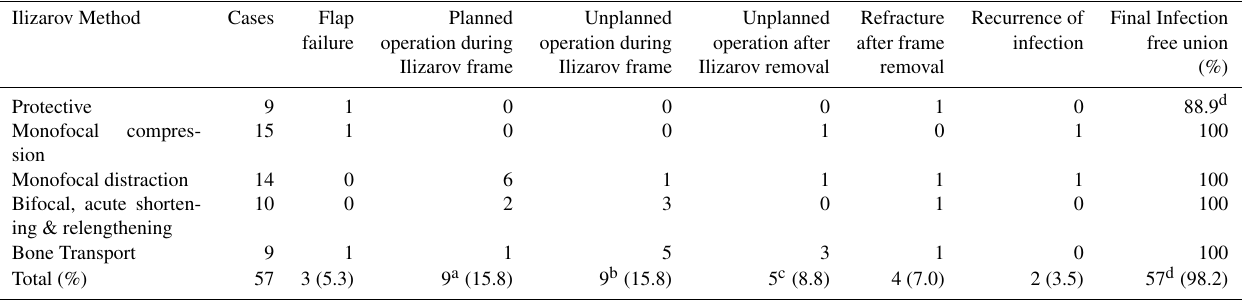
Table 4. Breakdown of outcomes for the different types of Ilizarov method used. Ilizarov Method